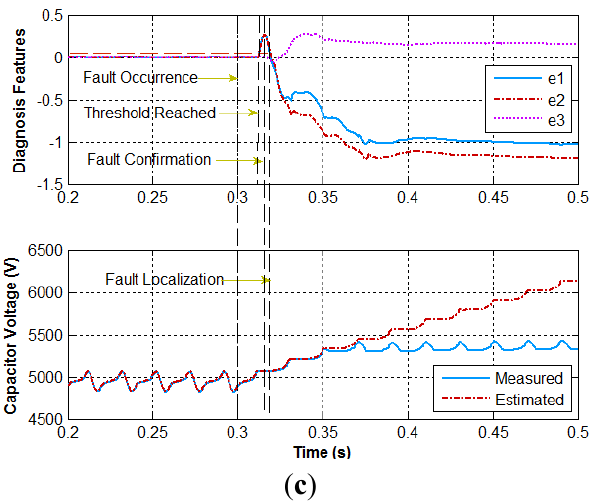
Figure 10. Open-circuit fault in T 1 under 20MW. ( a ) Output current and their averaged values; ( b ) Diagnosis features and capacitor voltages in SM1; ( c ) Diagnosis features and capacitor voltages in